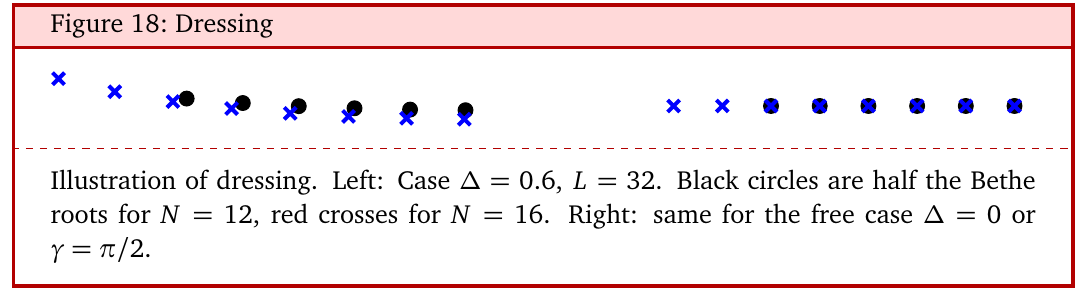
Illustration of dressing. Left: Case ∆ = 0.6, L = 32. Black circles are half the Bethe roots for N = 12, red crosses for N = 16. Right: same for the free case ∆ = 0 or γ = π/